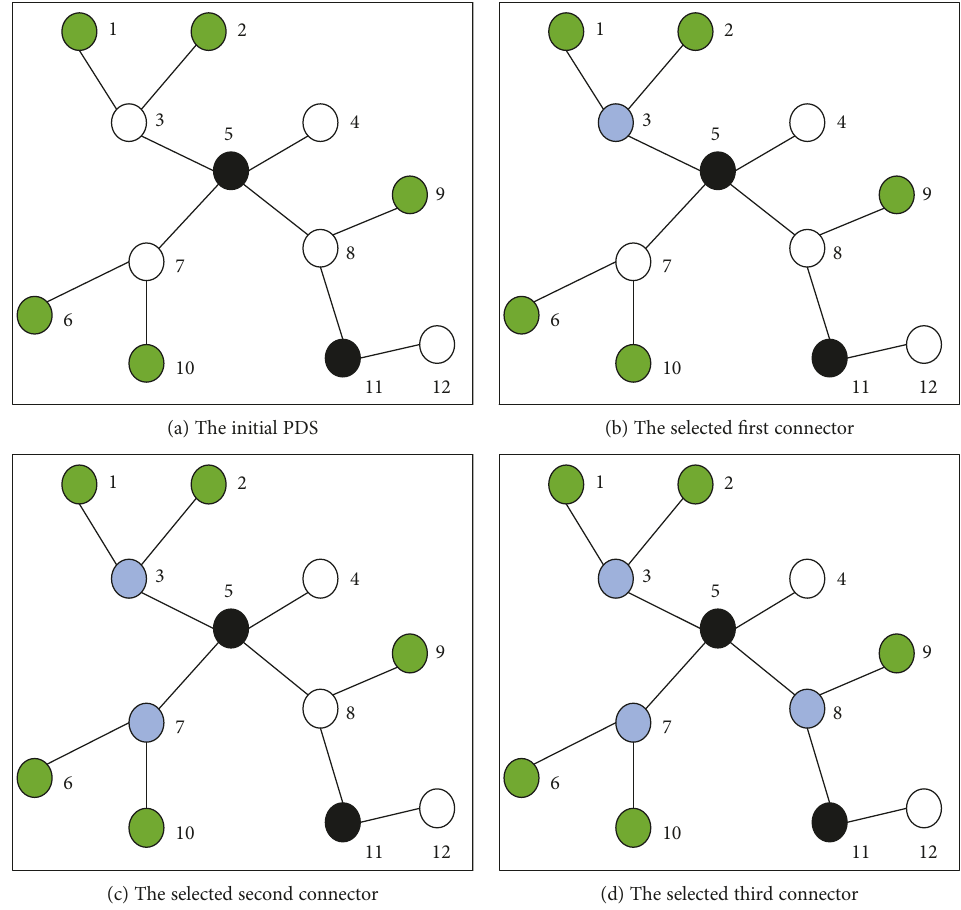
Figure 6: An example of connecting nodes in